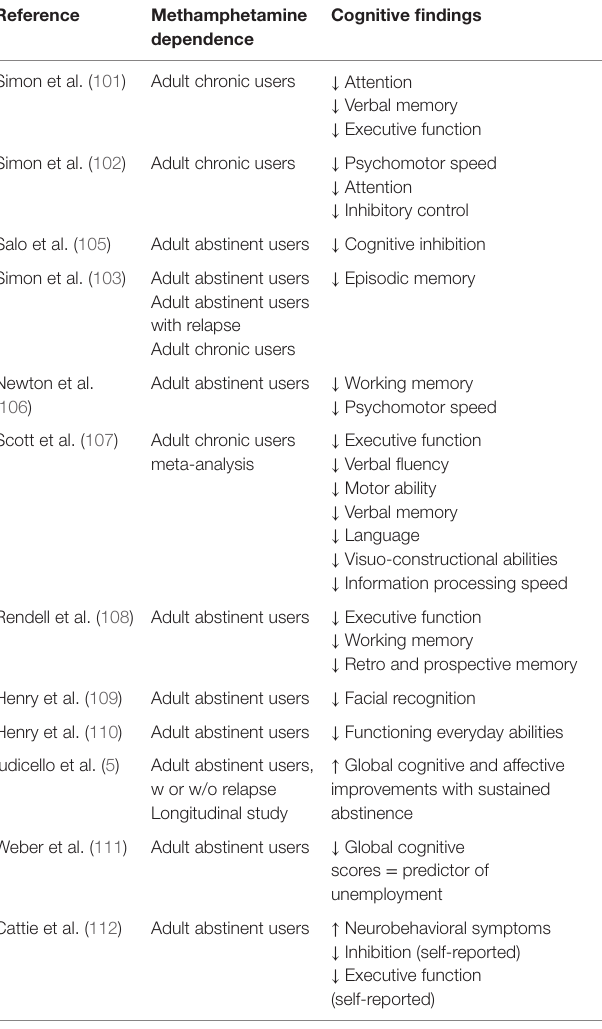
TABLe 6 | Functional neuroimaging studies on methamphetamine users performing cognitive tasks.